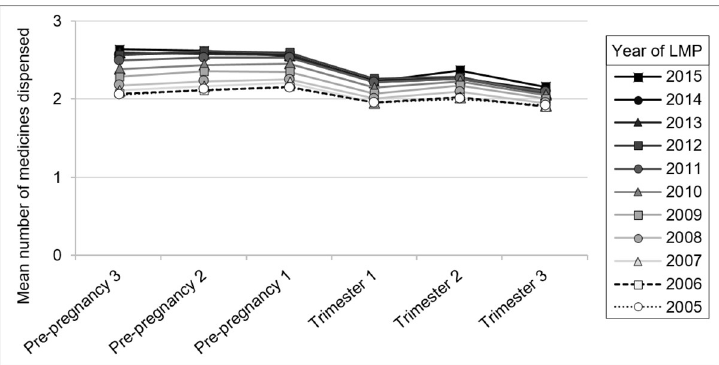
Fig 2. The mean number of different non-supplement prescription medicines dispensed to cohort members with at least one dispensing before and during pregnancy, 2005–2015. Pre-pregnancy 3 = 181–270 days pre-conception, Pre-pregnancy 2 = 91–180 days pre-conception, Pre-pregnancy 1 = 1–90 days